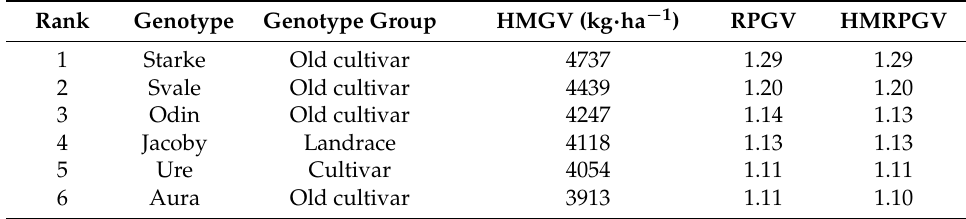
Table 5. Rankings of the winter wheat genotypes with the highest, most adaptable, and most stable yield according to genotypic values (BLUP). Values shown are the harmonic mean of genotypic values (HMGV), which illustrates stability; the relative performance of genotypic values (RPGV), which represents adaptability to unfavorable conditions; and the harmonic mean of relative performance of genotypic values (HMRPGV), which simultaneously denotes high yield, stability, and adaptability.